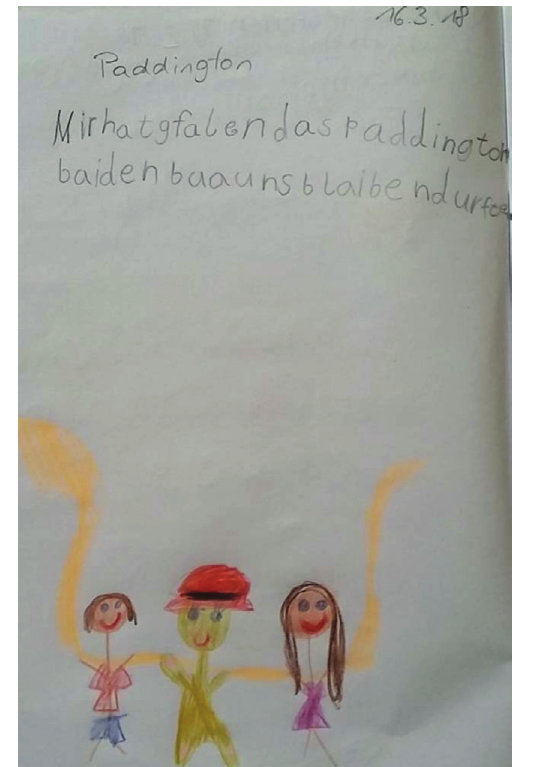
Figure 6: Primary school child’s commentary on the film Paddington : ‘I liked it that Paddington was allowed to stay with the